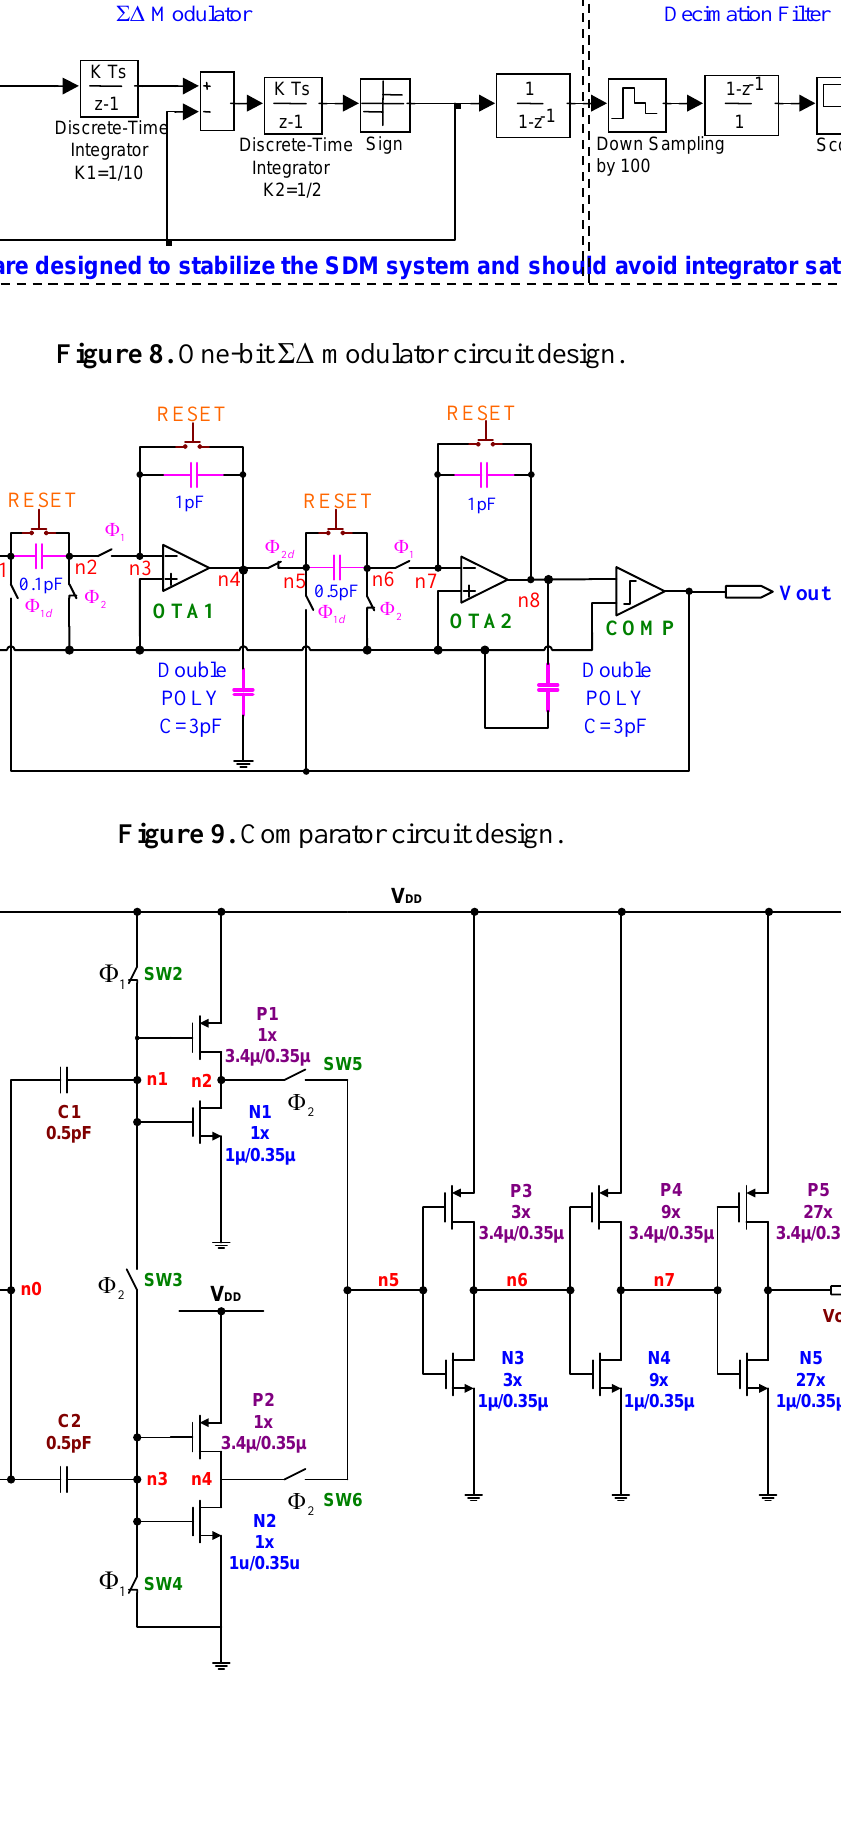
Figure 7. ΣΔ modulator behavior simulation.